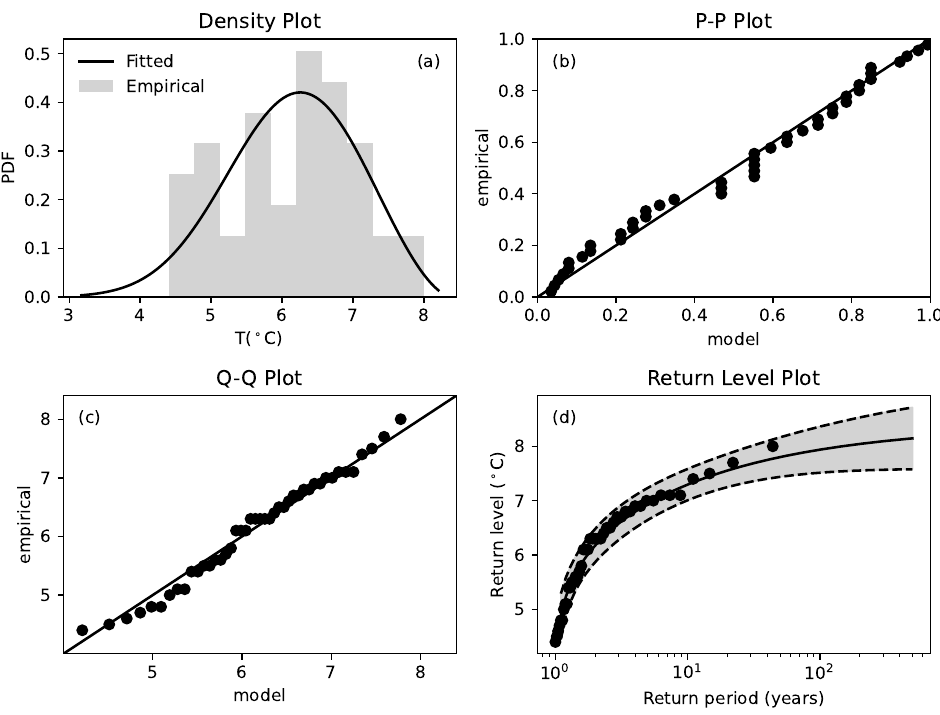
Figure 5. ( a ) Density plot, ( b ) probability plot, ( c ) quantile plot, ( d ) return level plot for the annual maximum temperature values at Rothera Met.